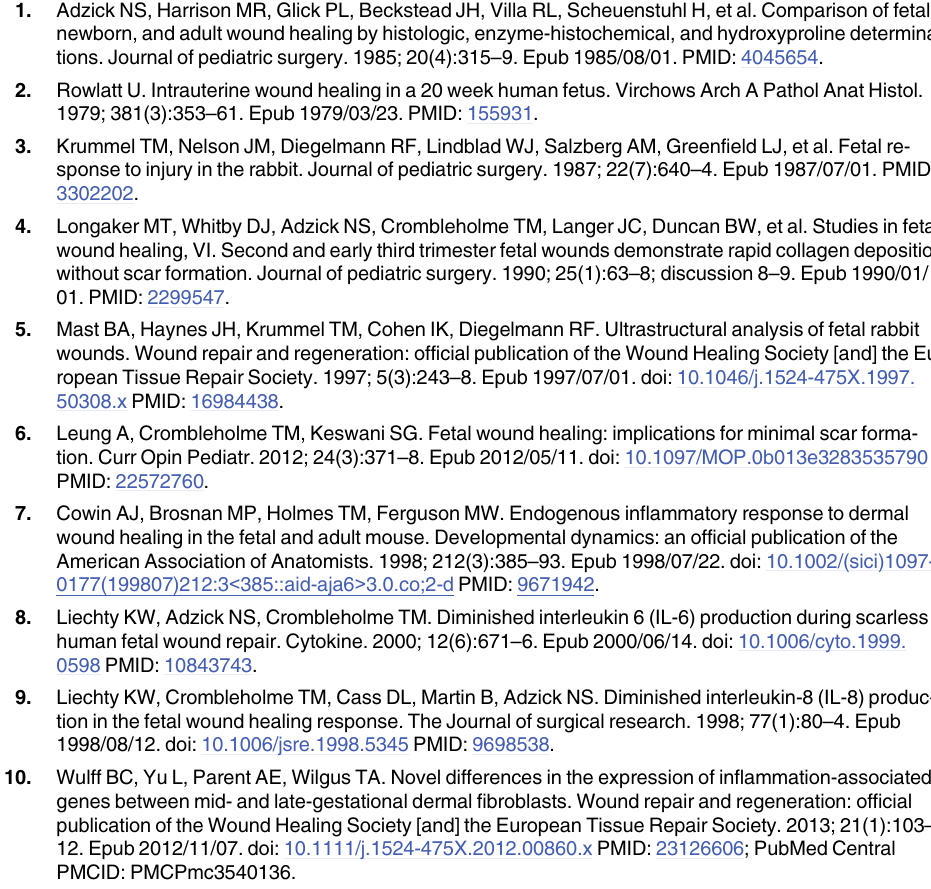
S4 Fig. IL-10 is essential to the dynamic phenotype of FFB described in Fig 1. IL-10 -/- FFB have a phenotype similar to the AFB. The rate of metabolic activity (A), migration (C) and in- vasion (D) of the IL-10-/- FFB is not statistically different when compared to AFB. Bar plots represent average±SD. Asterisks denote statistically significant differences between the groups ( (cid:1)(cid:1) p < 0.01; Student ’ s t-test; n = 3 per group at similar passage number; each experiment was conducted in triplicates with cells from independent isolations).